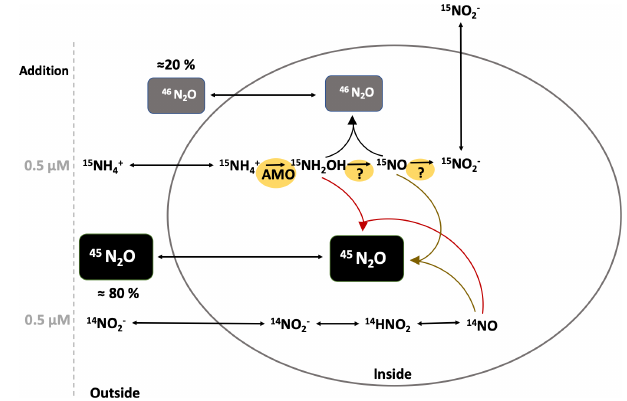
Figure 9. Scheme illustrating the possible reactions for hybrid N 2 O formation. The ellipse represents an AOA